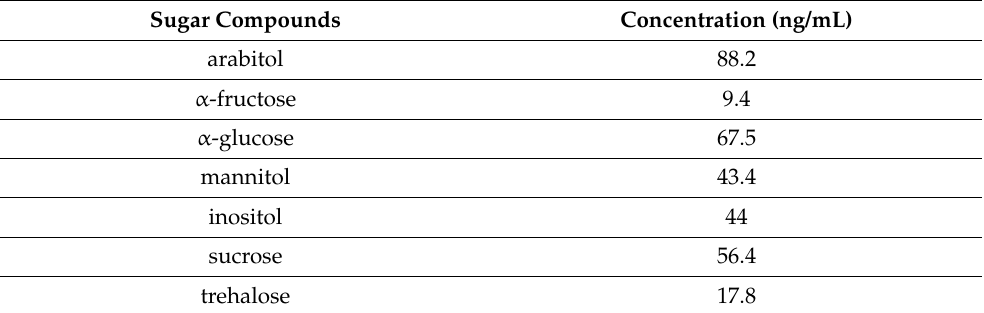
Table 2. Sugar compounds detected in water-extracts from fungal spore (171012 Fungi, Fuku- shima).